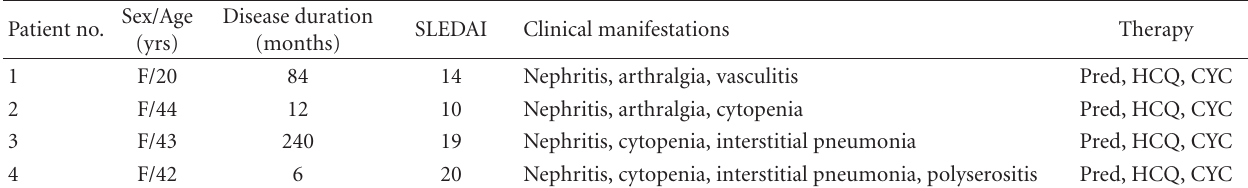
Table 1: Demographic data and clinical features of SLE patients for cDNA microarray analysis. Sex/Age Patient no.